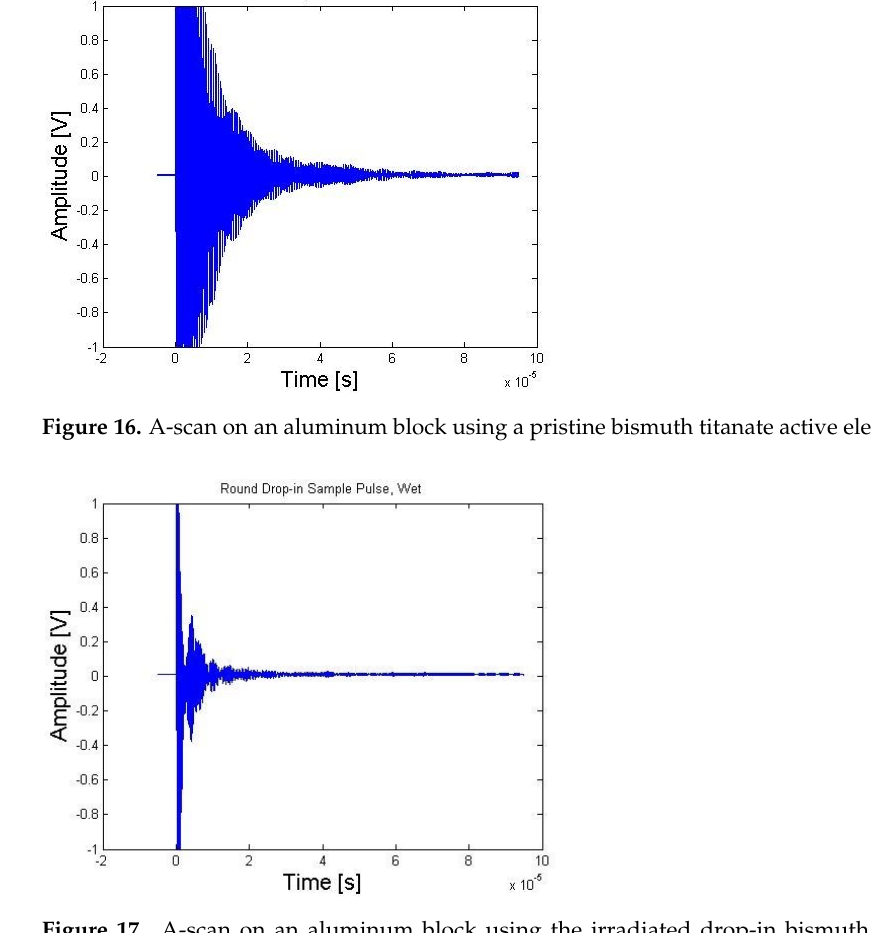
Figure 17. A-scan on an aluminum block using the irradiated drop-in bismuth titanate active element [14].